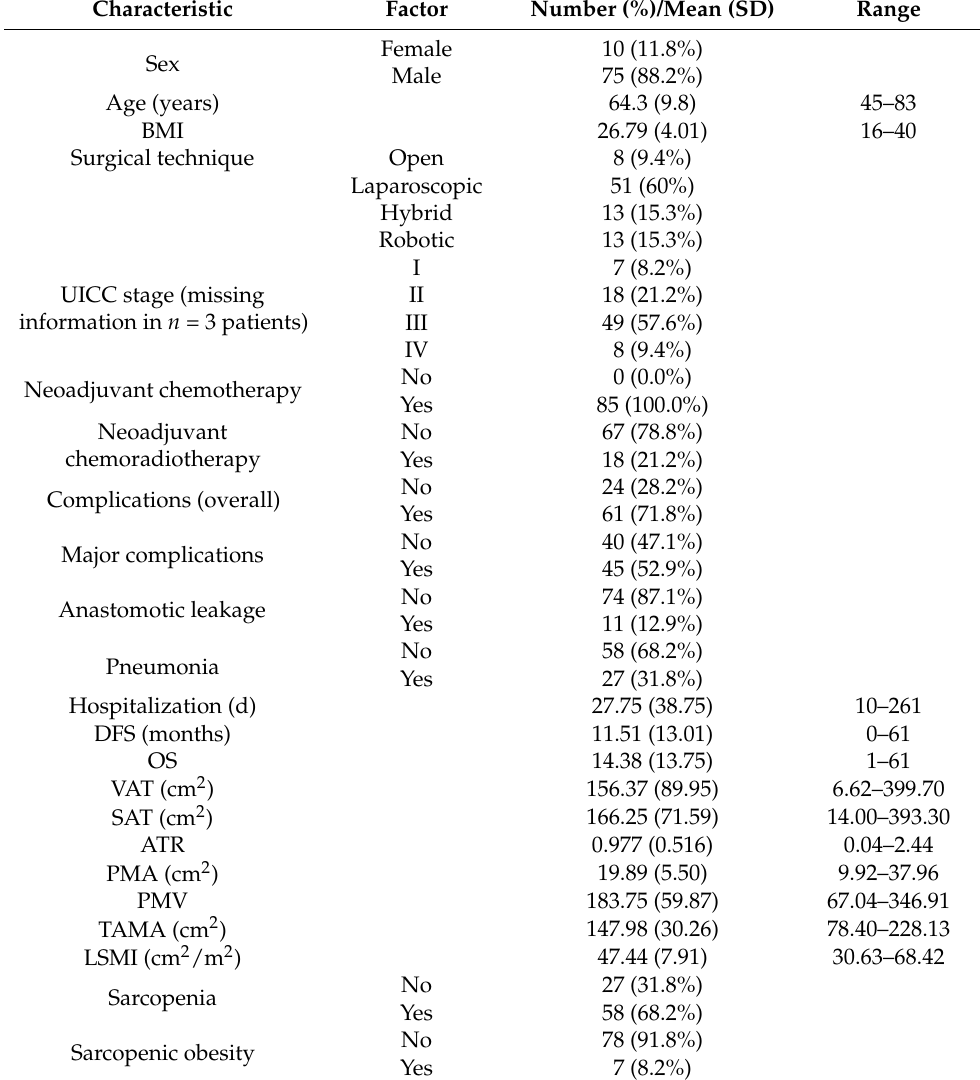
Table 1. Patient